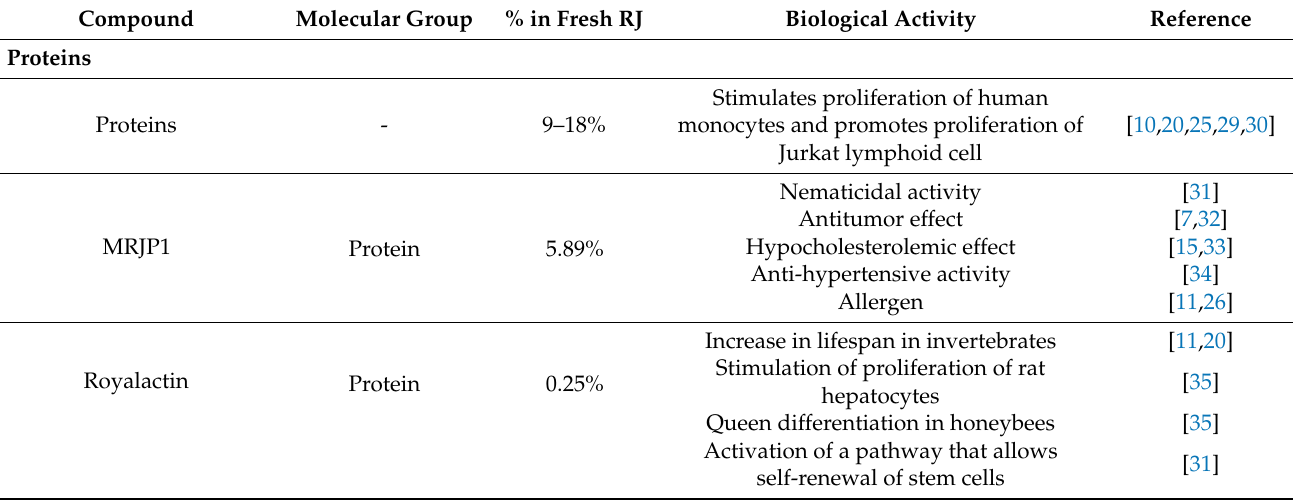
Table 1. Components of RJ related to their abundance and biological